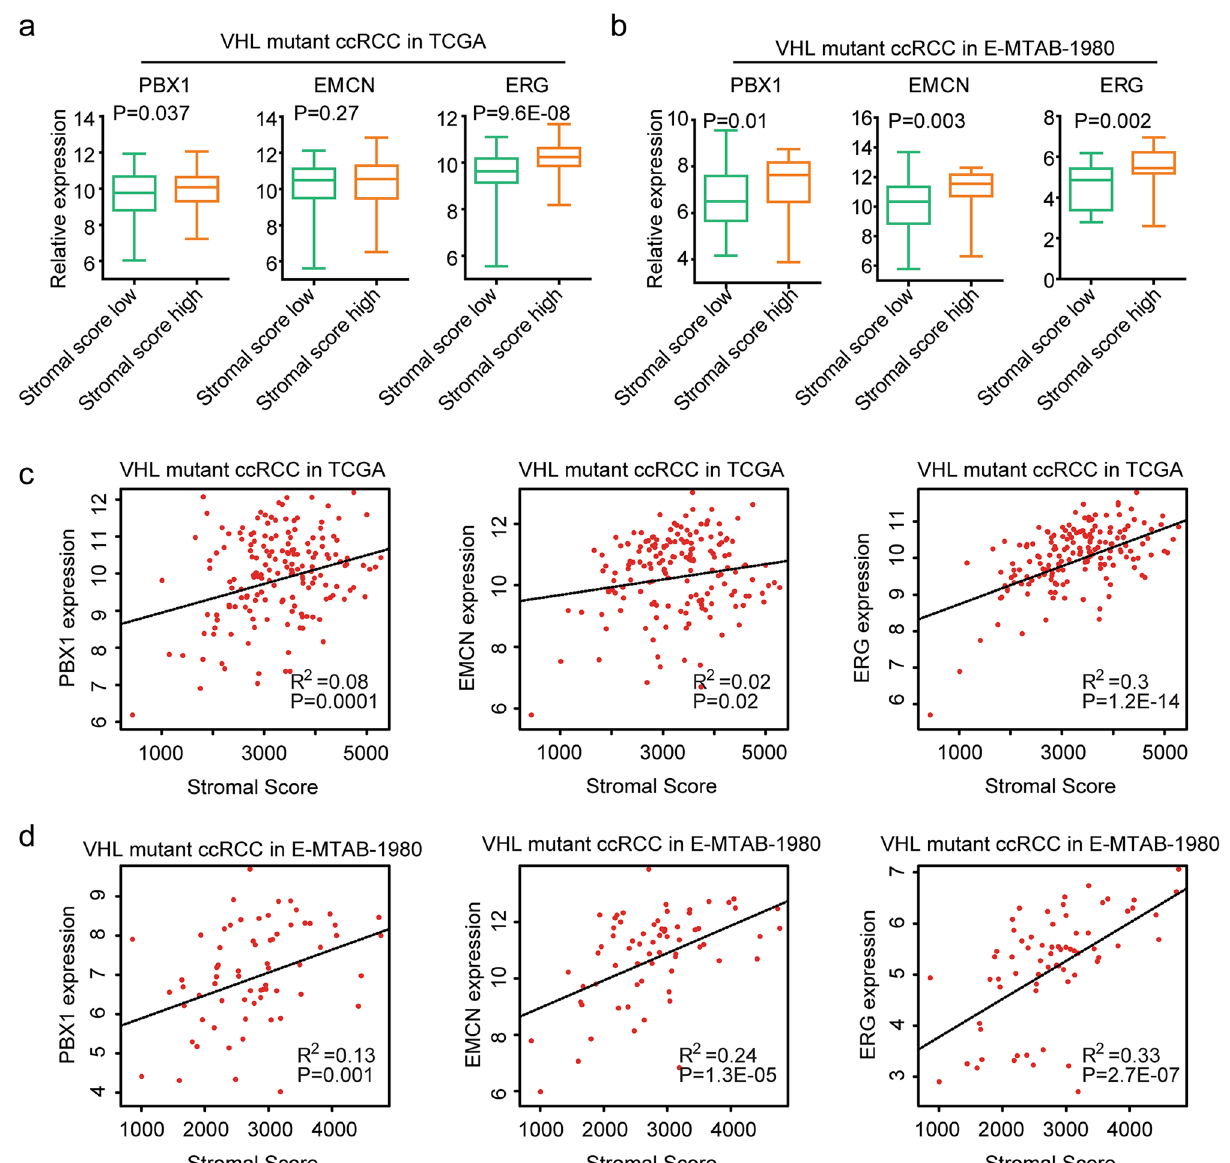
Figure 5. PBX1, EMCN and ERG are associated with the stromal score of VHL mutant ccRCC. ( a ) Box plots showed the PBX1, EMCN and ERG expression levels in VHL mutant ccRCC patients with higher stromal scores or with lower stromal scores in TCGA dataset. ( b ) PBX1, EMCN and ERG expression levels in VHL mutant ccRCC patients with higher stromal scores or with lower stromal scores in E-MTAB-1980 dataset. ( c ) Spearman correlations between PBX1, EMCN and ERG expression levels and stromal scores in VHL mutant ccRCC patients in TCGA dataset. ( d ) Spearman correlations between PBX1, EMCN and ERG expression levels and the stromal scores in VHL mutant ccRCC patients in E-MTAB-1980 factor in VHL mutant ccRCC in TCGA dataset (Fig. 7a). However, in both TCGA and E-MTAB-1980 datasets, PBX1, EMCN and EGR were not independent prognostic factors (Fig. 7a). We constructed risk models based on PBX1, EMCN and EGR expression features to predict the prognosis of VHL mutant ccRCC. The risk score of each patient in TCGA and E-MTAB-1980 datasets was obtained using RiskScore calculation formula. High risk or low risk subgroup was classified based on the median values of the risk score. The risk score distribution of each patient in TCGA and E-MTAB-1980 datasets was shown in Fig. 7b. With the increase of the risk score, the number of death of VHL mutant ccRCC patients was increased in TCGA and E-MTAB-1980 datasets (Fig. 7b). Moreover, lower expression levels of PBX1, EMCN and EGR were positively correlated with the risk score in VHL mutant ccRCC patients in TCGA and E-MTAB-1980 datasets (Fig. 7b). Construction of risk models of ccRCC based on PBX1, EMCN and EGR expressions. PBX1, EMCN and EGR were also associated with the overall survival of ccRCC. We determined the associations of